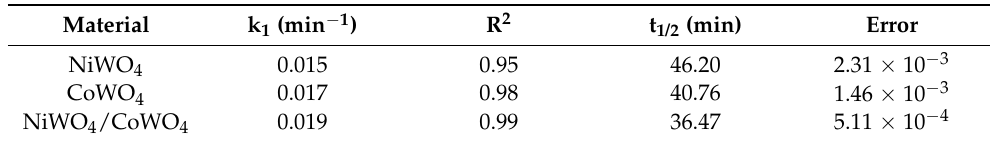
Table 2. Pseudo-first-order kinetic parameters for the photocatalytic degradation of paracetamol by synthesized NiWO 4 , CoWO 4 , and NiWO 4 /CoWO 4 NC.